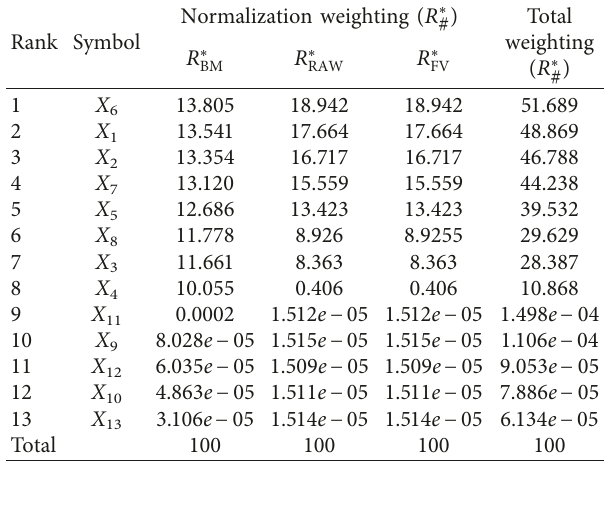
Table 16: Ranking results of the key events.